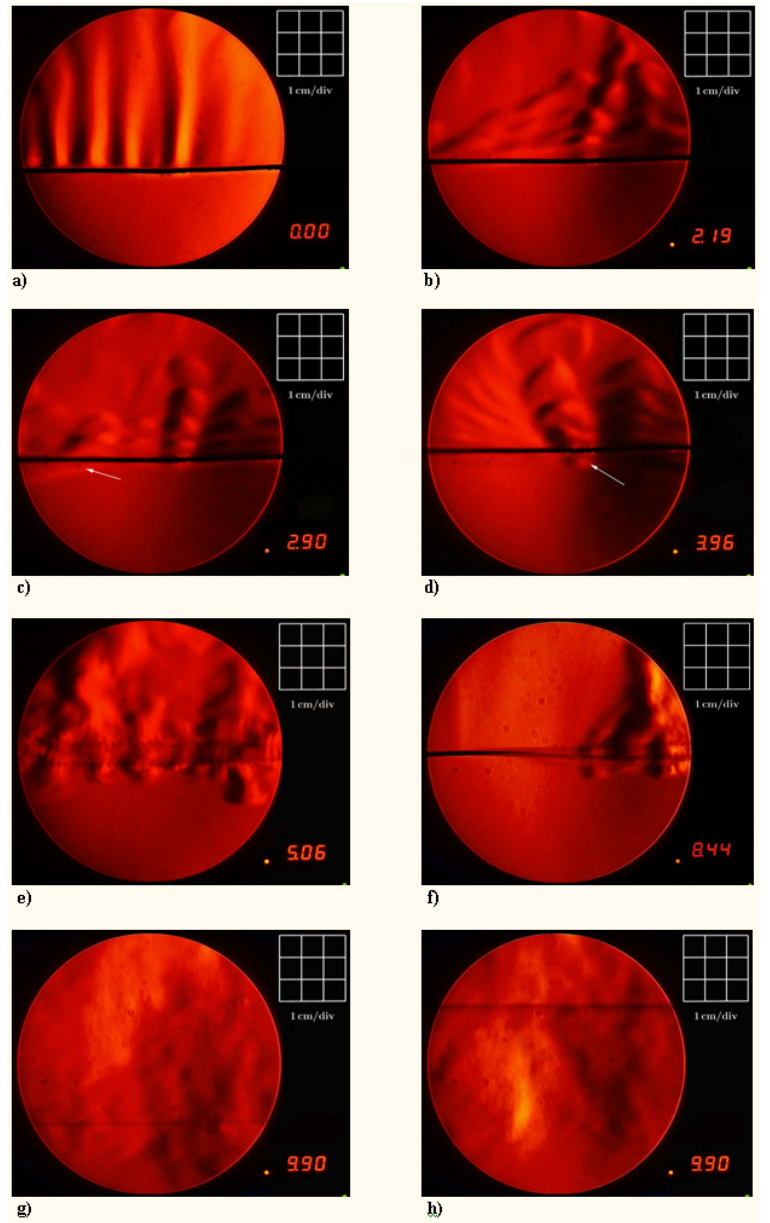
Figure 6. Typical images of convective flow during TMO for a (Kanthal A)-wire of thickness d = 0.6 mm at an intial temperature difference of ∆ T ( t = 0 ) = 100 K (see Equation (4)), a stress pulsation of ∆ σ = 8.7 MPa and fundamental frequency ν 0 = 5 Hz. The modulation frequency ν was increased from 0 to 15 Hz to produce the oscillations shown (the respective value of ν in Hz is indicated by the number at the bottom right of each picture). ( a ) Fixed heater at ν = 0, where 2 A = 0 holds ( A is the amplitude of the wire deflection), laminar flow convection ( Re (cid:39) 106), α 0 (cid:39) 130 W/m 2 K. ( b ) Mechanical vibrations of small amplitude ( ν = 2.19 Hz, 2 A = 1.5 mm), modulation depth µ ≈ 15%. ( c , d ) The forming of hot air zone under the heater indicated by (arrows): ν = 2.9 Hz and 2 A = 2mm in ( c ), ν = 3.96 Hz and 2 A = 4 mm in ( d ). ( e ) TMO in a parametric instability area (2nd resonance, n = 2); ν = 5.06 Hz and 2 A = 12 mm. Powerful ejections of hot air under the heater are observed. ( f ) Generation of high-order harmonics of TMO (two antinodes), ν 0 = 8.44 Hz and 2 A = 8 mm. ( g , h ) Maximum TMO intensity at the 1st resonance ( n = 1), ν = 9.9 Hz, and 2 A = 52 mm, α (cid:39) 159 W/m 2 K. The lowest ( g ) and the highest position ( h ) of the heater is shown. Passing the equilibrium position the heater is shrouded in a dense convective flow and hardly